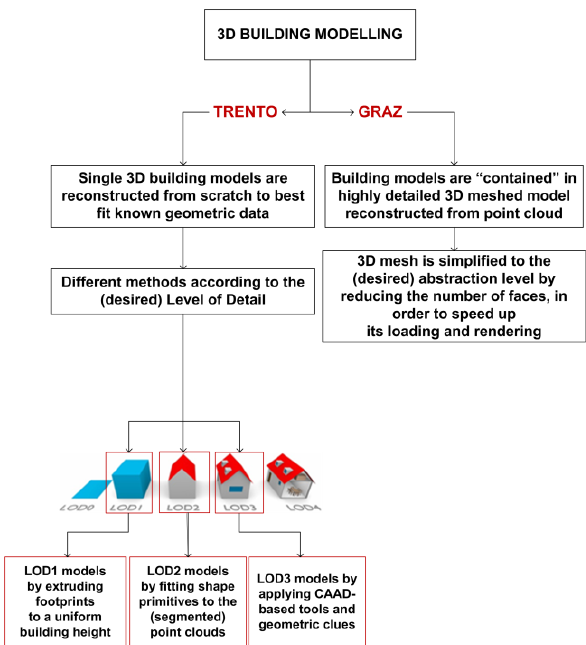
Figure 3. Workflow adopted for modelling the building geometries (partially based on TU Delft - www.tudelft.nl) Both aforementioned approaches are employed within the SENECA project (Figure 3).